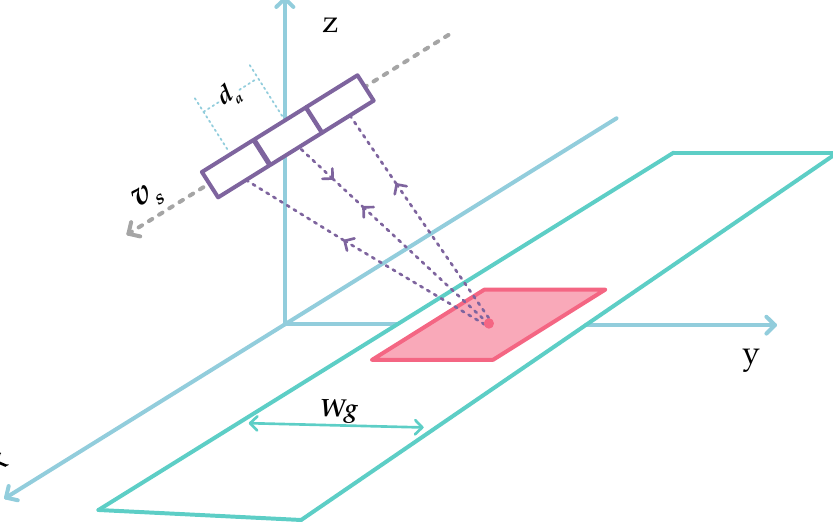
Figure 1. The geometry of an azimuth MC-SAR system.